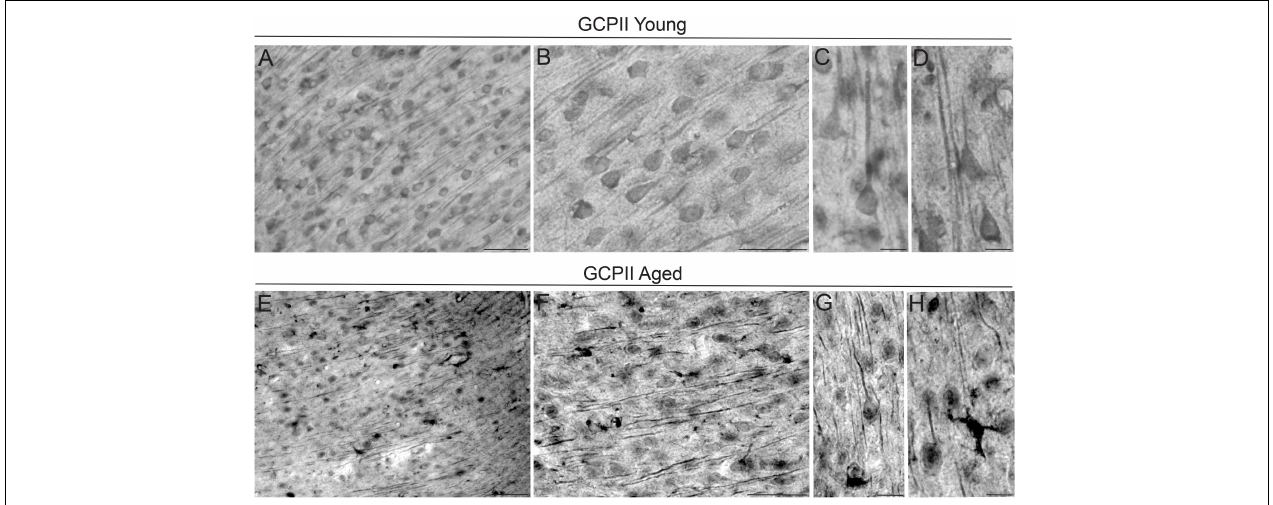
FIGURE 1 | GCPII labeling by IHC in young and aged rat layer II/III PL PFC. (A) Immunolabeling for GCPII in young adult rat layer II/III PL mPFC revealing expression in multiple cell-types. Scale bar: 30 µ m. (B) High-magnification micrograph for GCPII in young rat layer II/III PL mPFC revealing expression in glial cells and neurons. Pyramidal neurons in layer II/III were immunolabeled against GCPII, especially with staining found in the pyramidal perisomatic compartment, and diffuse labeling along apical dendrites. Scale bar: 30 µ m. (C,D) High-resolution micrographs revealing GCPII immunolabeling in pyramidal cells in young rat layer II/III PL mPFC. Scale bars: 10 µ m. (E) Expression of GCPII in aged rat layer II/III PL mPFC revealing aggregates of GCPII protein within intracellular compartments in multiple cell-types. (F) High-magnification micrograph for GCPII protein in aged rat layer II/III PL mPFC showing accumulation of GCPII protein within pyramidal cell apical dendrites and in non-neuronal cells. (G) High-resolution micrograph revealing GCPII immunolabeling in pyramidal cells and in apical dendrites traversing through the neuropil in aged rat layer II/III PL mPFC. Scale bar: 10 µ m. (H) GCPII labeling was also observed in non-neuronal glial cells, extending delicate processes in the neuropil. Scale bar: 10 µ